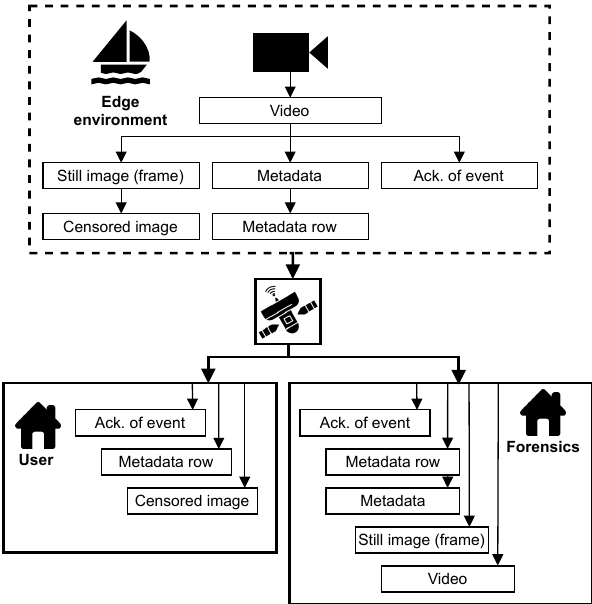
Figure 2. Example of a multimedia data pipeline transmitting information extracted from a video recording from an edge device, to two parties with differing privileges to view the